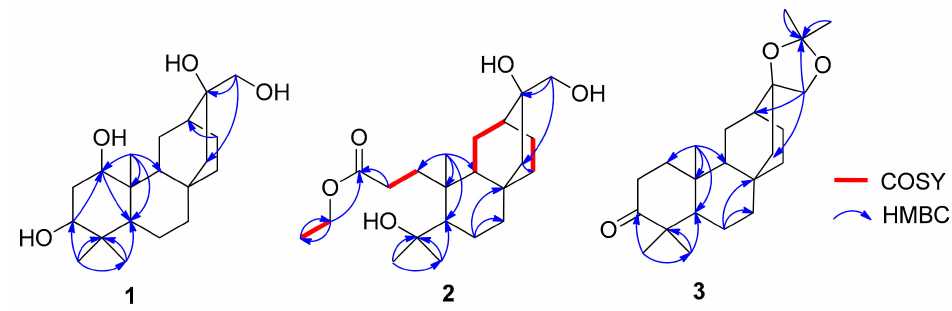
Figure 2. Key COSY and HMBC correlations of 1 – 3 .